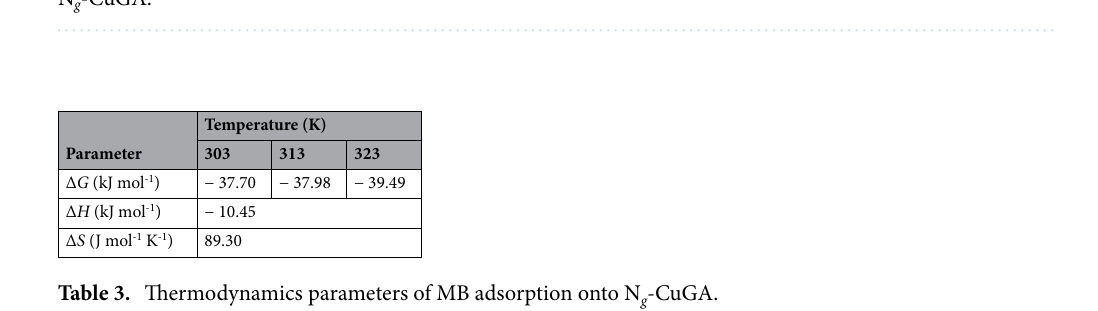
Table 2. Experimental maximum capacity and calculated isotherm parameters for the adsorption of MB onto N g -CuGA.